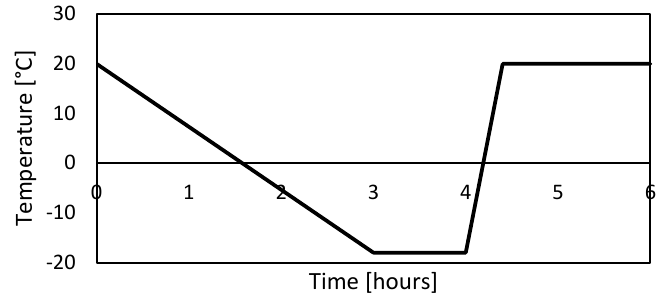
Figure 3. The regime of a freeze-thaw cycle.